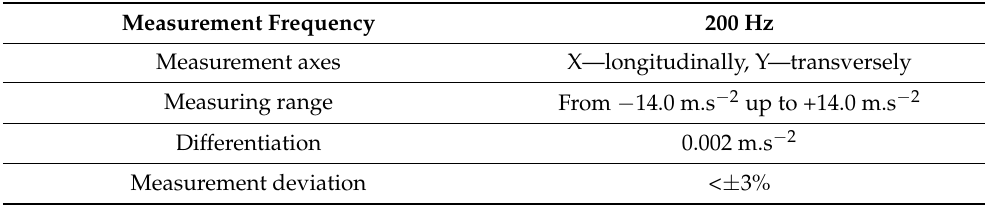
Table 3 . Technical parameters of the decelerometer used for the measurements [91] . Table 3. Technical parameters of the decelerometer used for the measurements